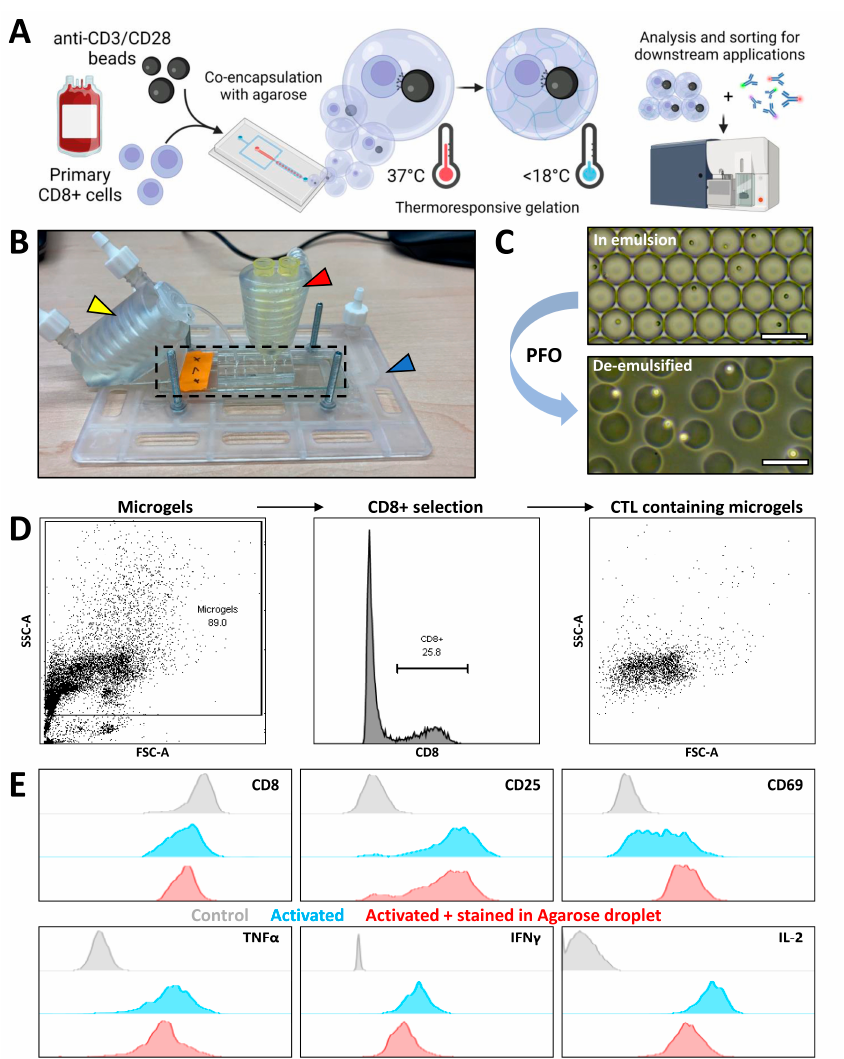
Figure 3. Encapsulation and flow cytometric measurement of CTL-containing agarose microgels. ( A ) Schematic of the workflow; cells are isolated and co-encapsulated with aAPCs in droplets along with agarose solution, droplets containing cells are cultured at 37 ◦ C to allow interaction after which temperature is decreased below 18 ◦ C to allow agarose to crosslink and create microgels containing cell pairs, microgels are retrieved and can be stained for membrane markers and measured or sorted using flow cytometry. ( B ) 3D printed temperature control devices. Device used to control temperature in pipette tips (red arrow) for injection of samples, microscope insert (blue arrow) containing microfluidic device (black dashed line), and heated holder for collection tube (yellow arrow). Hot water is flown through all devices in series to maintain 37 ◦ C during droplet formation and after collection. ( C ) Brightfield microscopy images of water-in-oil emulsion before crosslinking and of de-emulsified microgels in PBS. Scale bars = 100 µ m. ( D ) Gating strategy to retrieve cell- containing droplets; Microgels are gated based on the FSC/SSC of empty droplets, CD8+ events are selected. ( E ) Histograms depicting the effect of antibody staining in agarose hydrogels compared to staining in conventional cell solution. Comparing unstimulated control stained in solution (grey), PMA/Ionomycin bulk stimulated cells stained in solution (blue), PMA/Ionomycin bulk stimulated cells stained in microgels